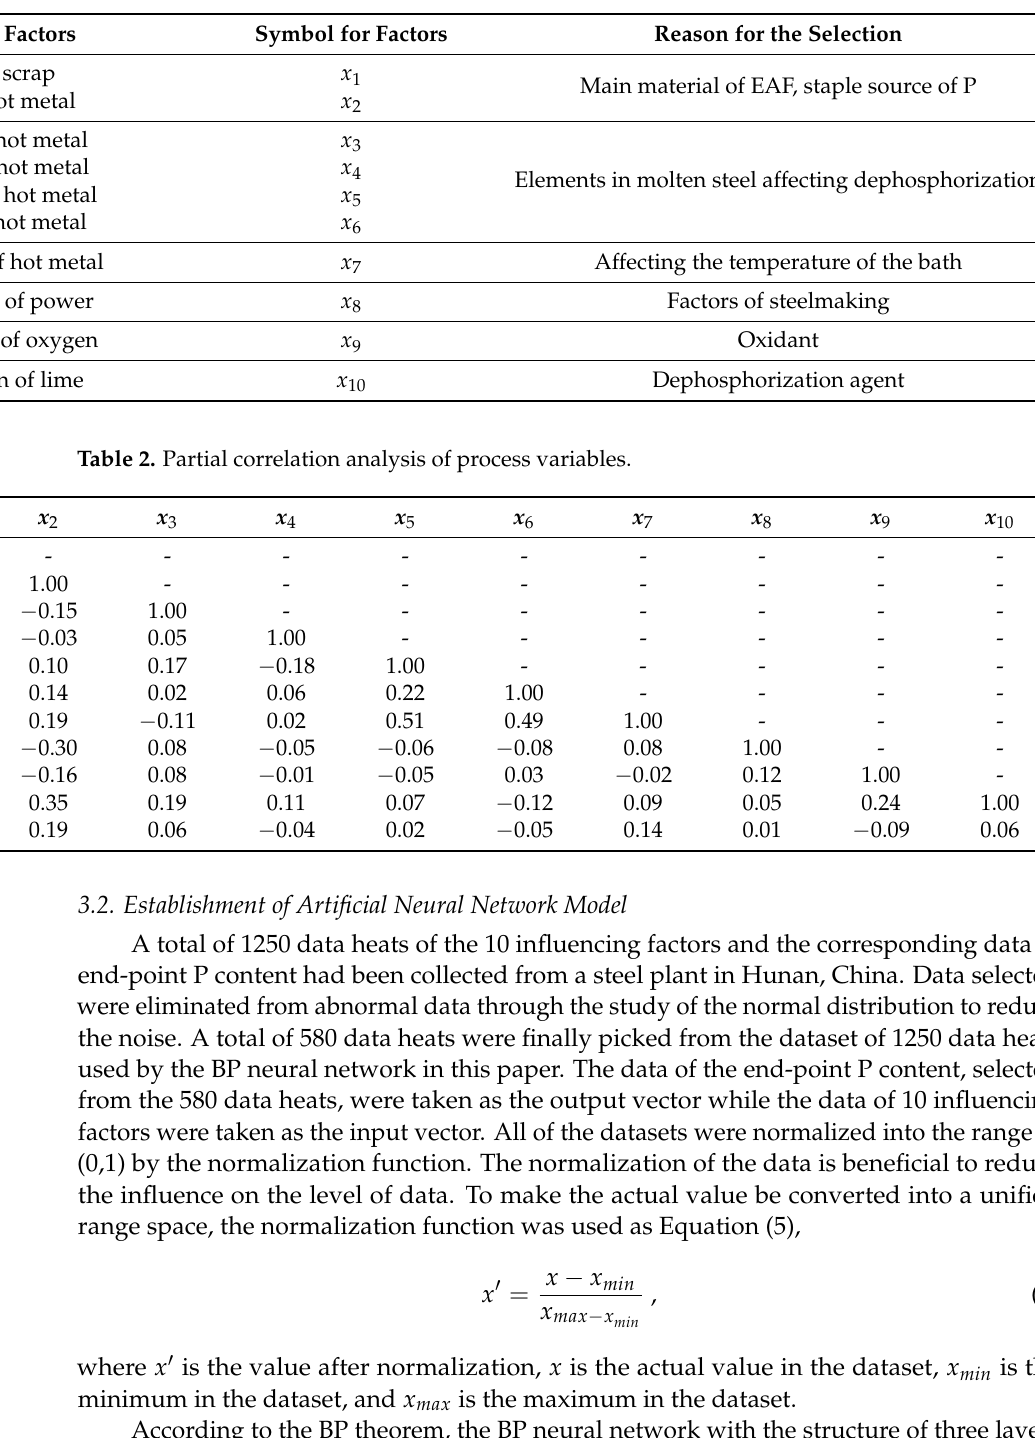
Table 1. Preliminary selection for influencing factors and reasons for end-point phosphorus (P)